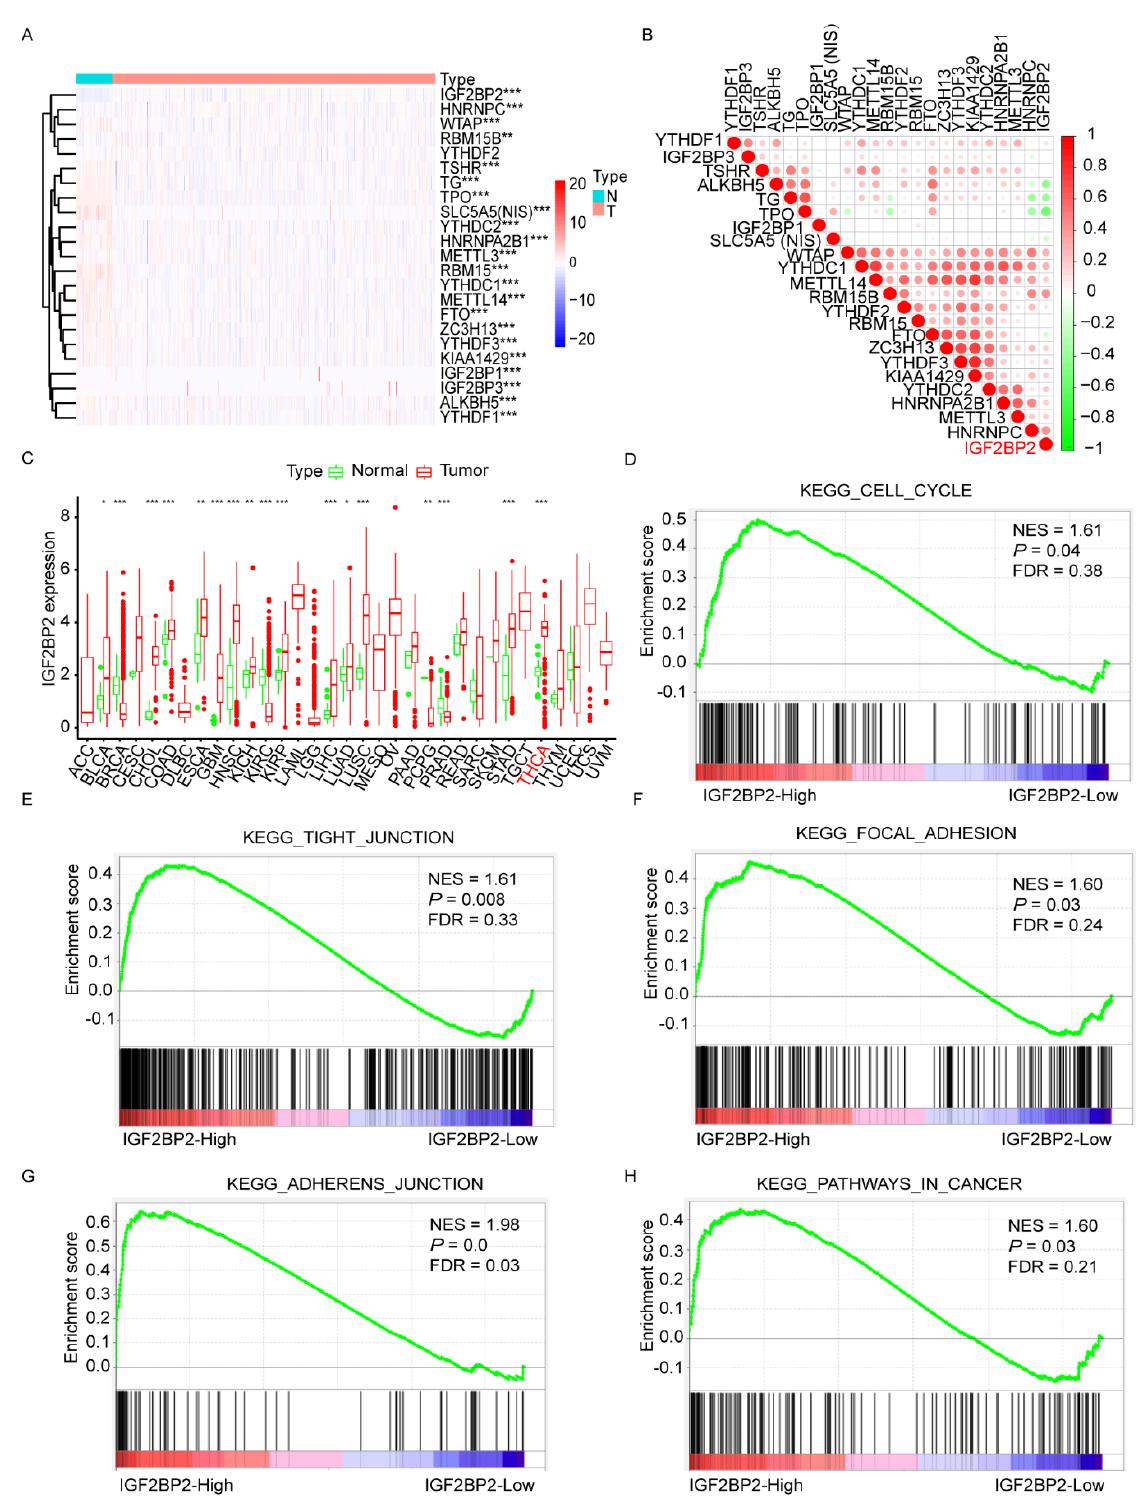
Figure 1. Negative association between the expression of IGF2BP2 and iodide-handling genes. ( A ) Expression of m6A RNA methylation regulators in thyroid cancer and normal thyroid. * p < 0.05, ** p < 0.01, *** p < 0.001. ( B ) Negative association between the expression of IGF2BP2 and iodide- handling genes. ( C ) Expression levels of IGF2BP2 in multiple cancers. GSEA plots showing that high IGF2BP2 expression is positively related to cell cycle ( D ), tight junction ( E ), focal adhesion ( F ), adherens junction ( G ), pathways in cancer ( H